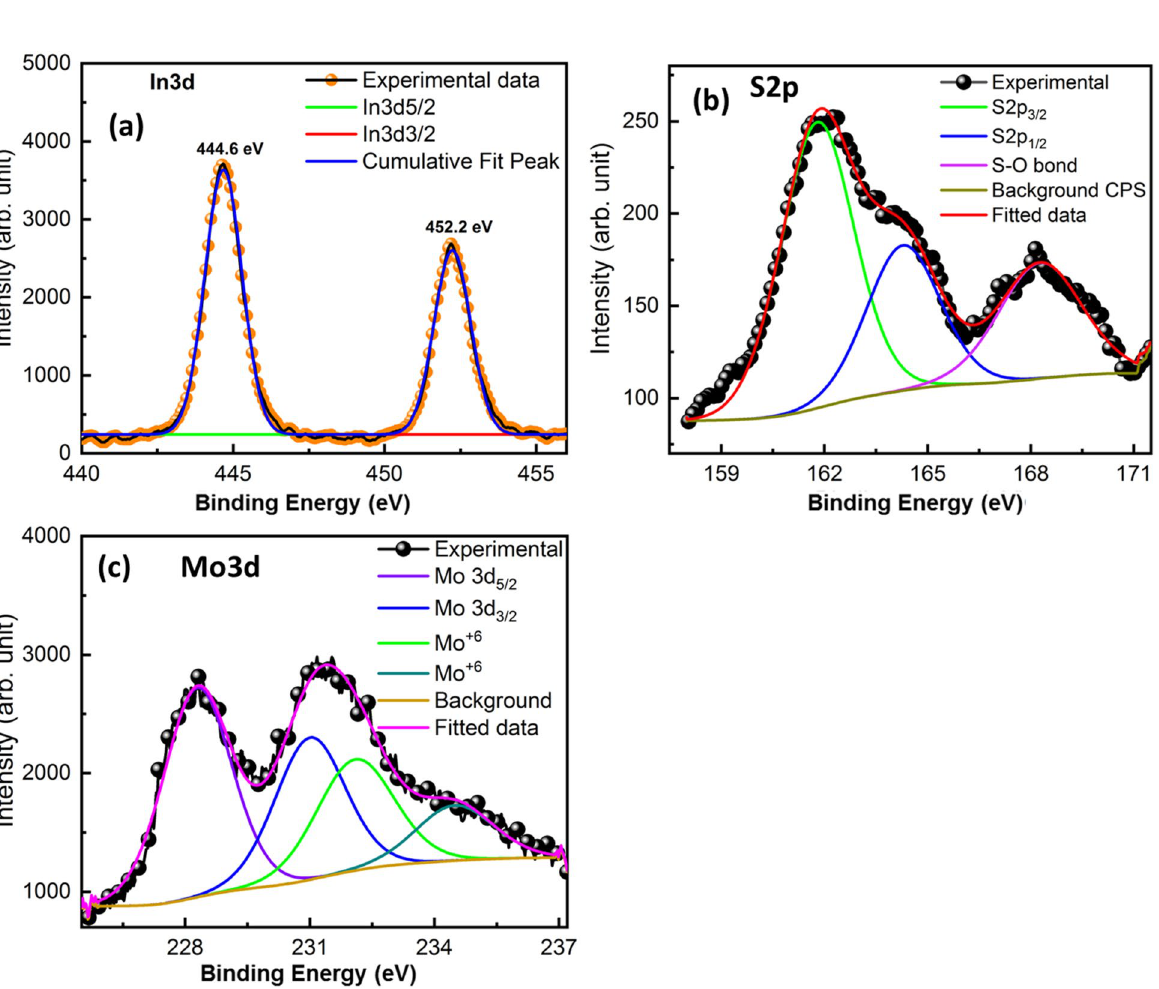
Figure 7. ( a ) Fitted XPS spectrum of In3d, ( b ) Fitted XPS spectrum of S2s, ( c ) Gaussian fitted XPS of